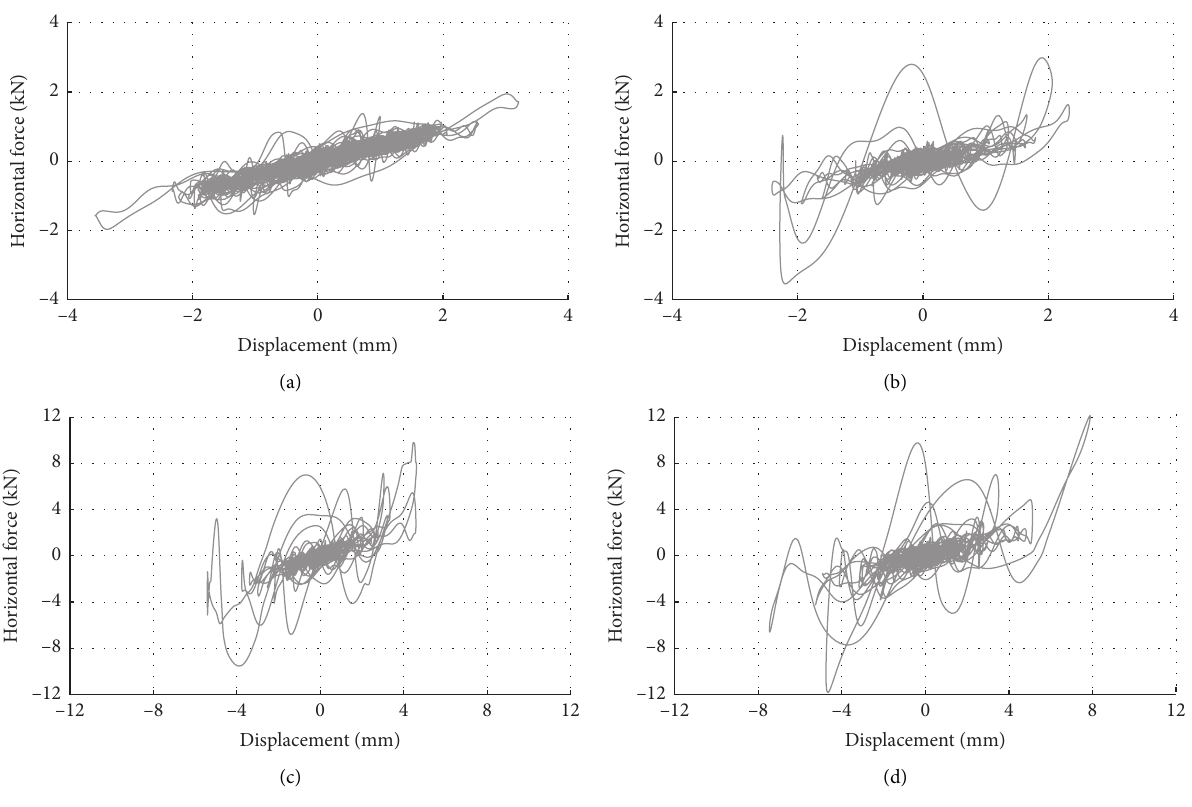
Figure 8: Hysteresis loops: (a) WL0, (b) WL1, (c) WL2, and (d)